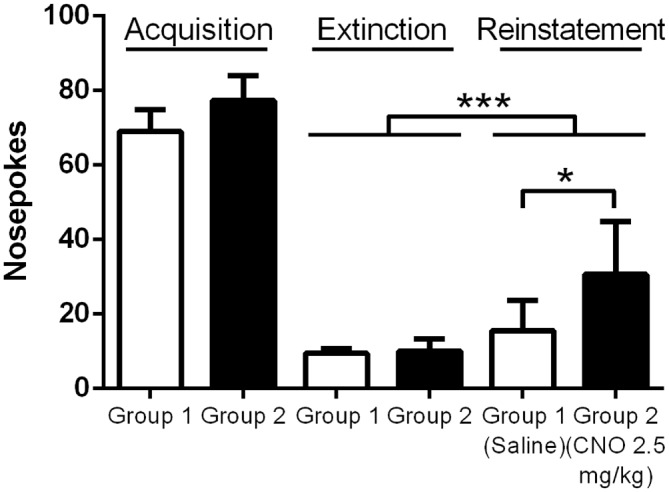
Exciting mPFC PN enhances reinstatement of food seeking. Note: Saline or CNO was administered only during the reinstatement test; the groups are separated during Acquisition and Extinction to demonstrate nose poking in each group. Mice in both the Saline (N = 8) and CNO (N = 9) groups successfully reinstated nose poking behavior during the Reinstatement test. Mice given CNO poked significantly more than mice given saline during the test. Error bars are ± SEM. *p < 0.05, ***p < 0.001, 2-way rmANOVA followed by Sidak’s multiple comparisons test.